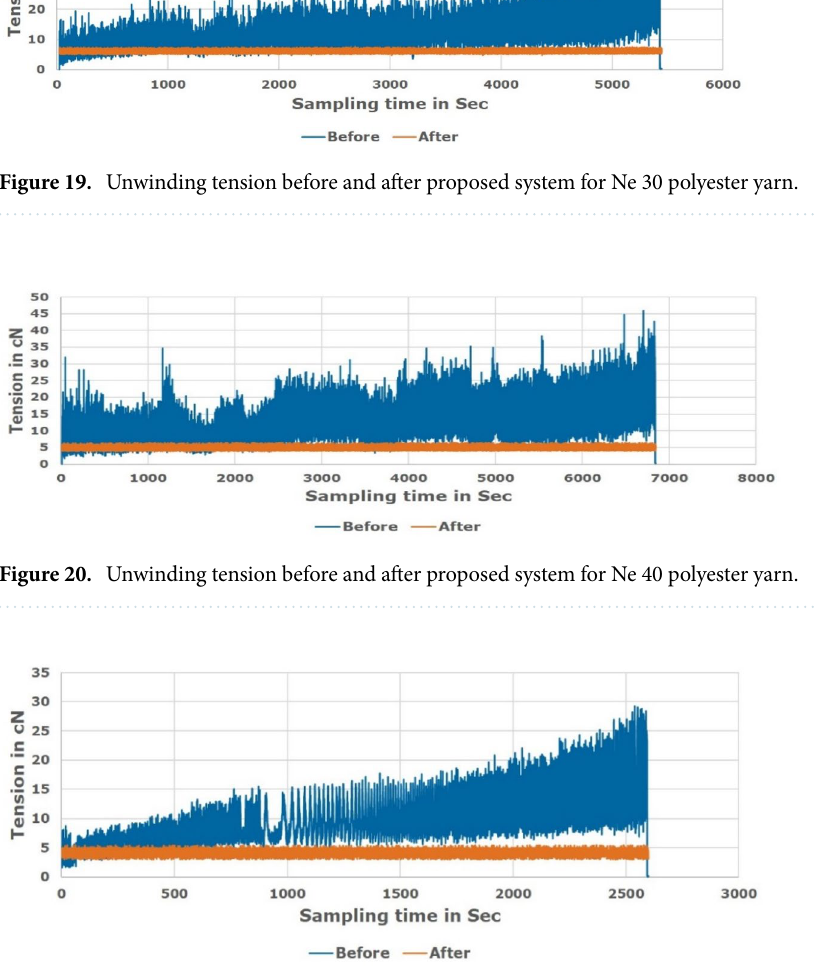
Figure 21. Unwinding tension before and after proposed system for Ne 50 polyester